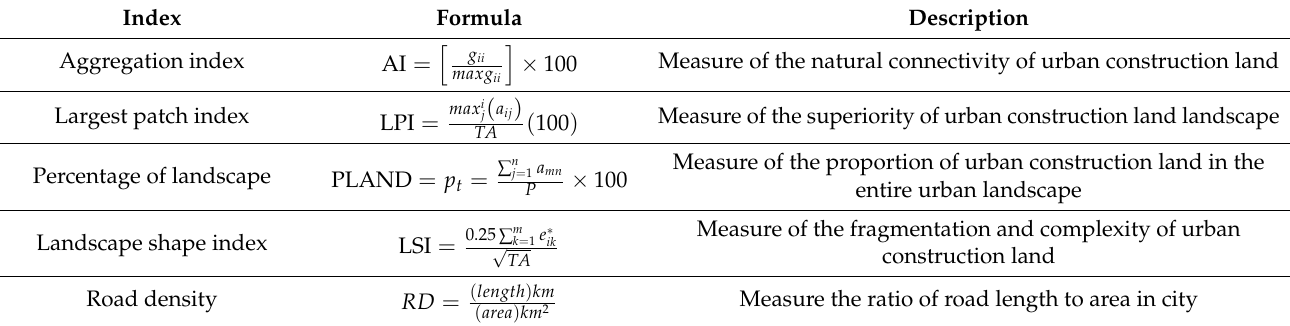
Table 2. Main urban form indexes in this